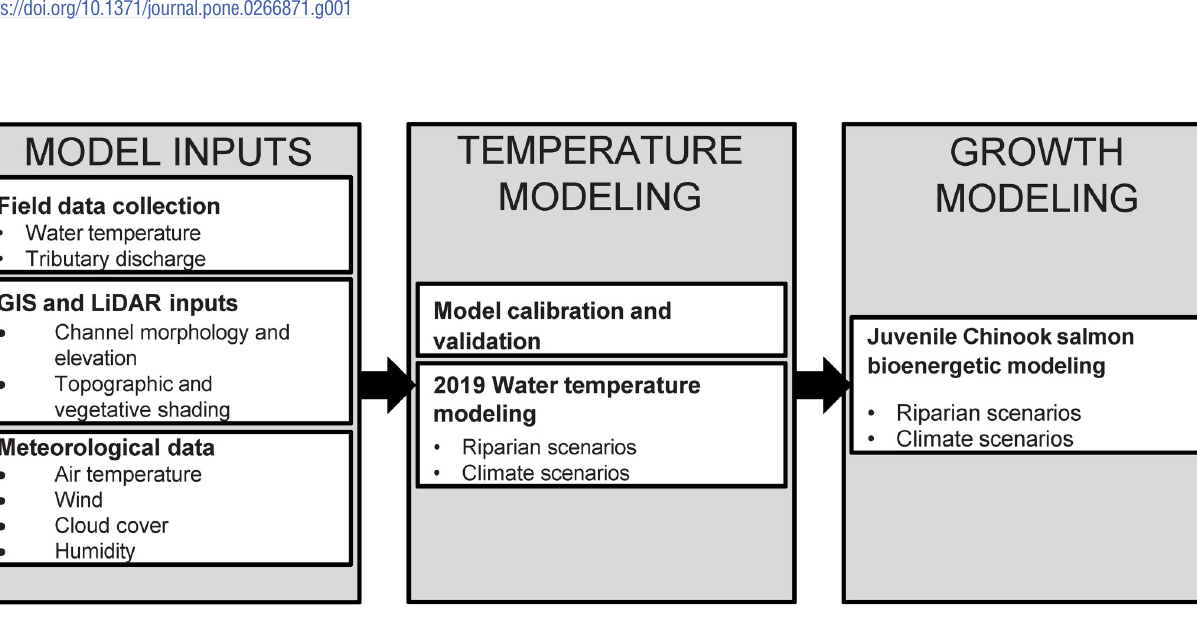
PLOS ONE | https://doi.org/10.1371/journal.pone.0266871 May 20, 2022 4 /